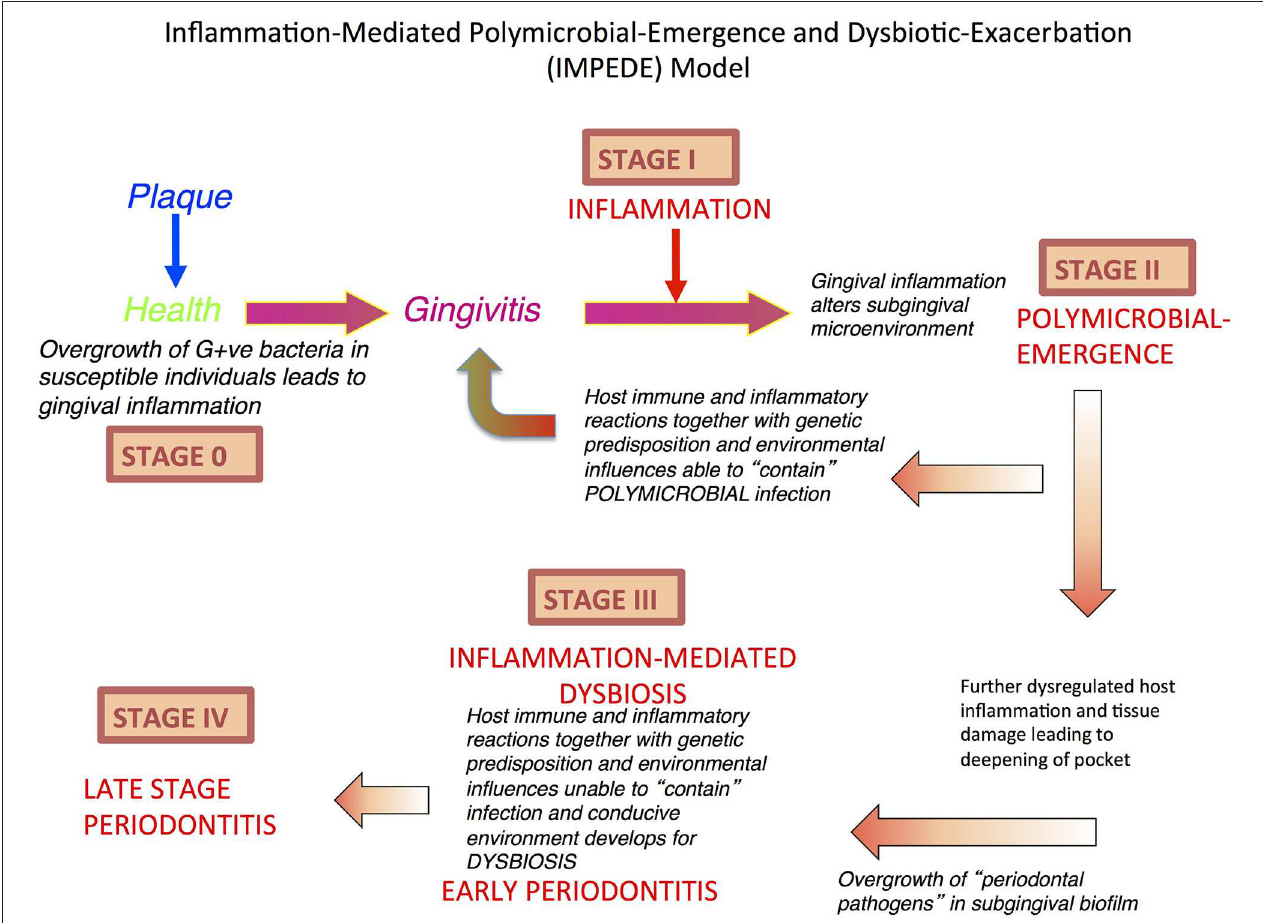
FIGURE 1 | Inflammation-Mediated Polymicrobial Emergence and Dysbiotic Exacerbation (IMPEDE) Model. A proposal to demonstrate how inflammation is a principal driver of plaque-associated periodontitis. This model recognizes 5 stages (0-IV) through which health, gingivitis, and periodontitis may develop, be contained or progress. Stage 0: periodontal health; Stage I: Gingivitis (inflammation); Stage II: Initiation/early periodontitis (Polymicrobial diversity emerges); Stage III: Inflammation mediated dysbiosis and opportunistic infection and Stage IV: Late stage periodontitis.